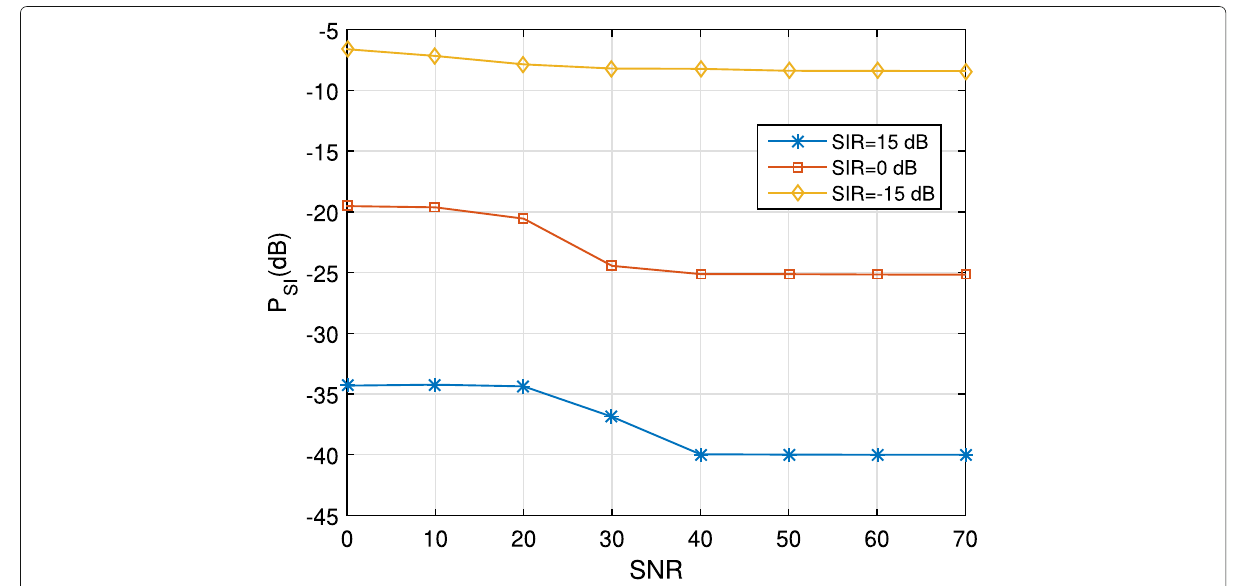
Fig. 5 The residual SI power P SI after digital cancelation